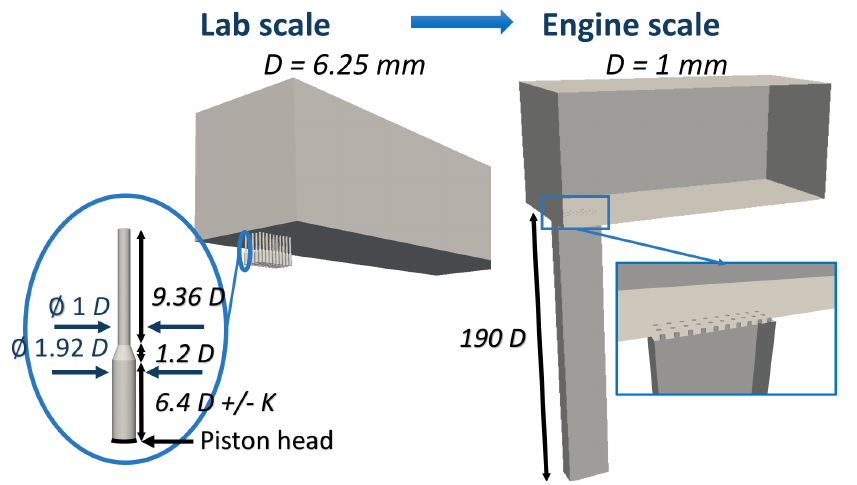
Figure 3. Comparison of the two